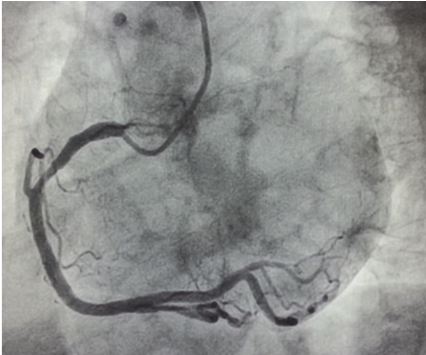
Figure 4: Super dominant RCA arising from right sinus in left anterior oblique